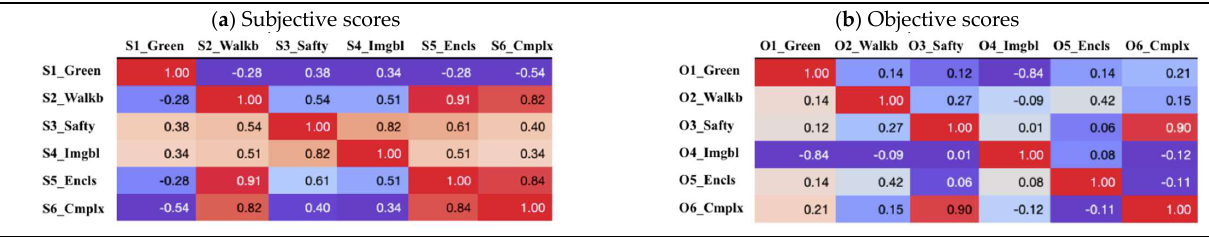
Figure 8. Pearson’s correlation coefficients among the ( a ) six subjective scores and ( b ) six objective scores.